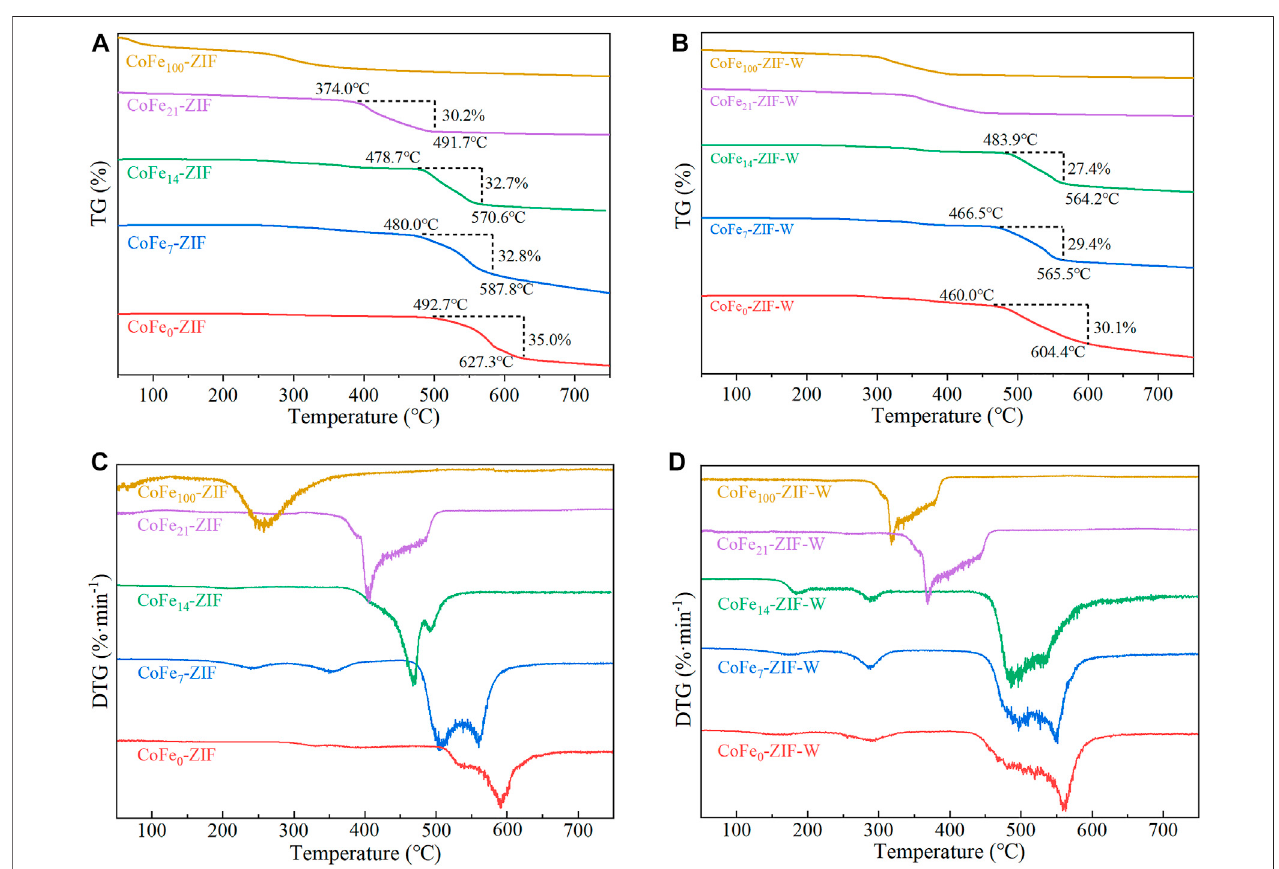
FIGURE 4 | TG analysis of catalysts under different preparation conditions (A) thermo dissolution method (B) microwave dissolution method (C) DTG of thermal dissolution method (D) DTG of microwave dissolution method.